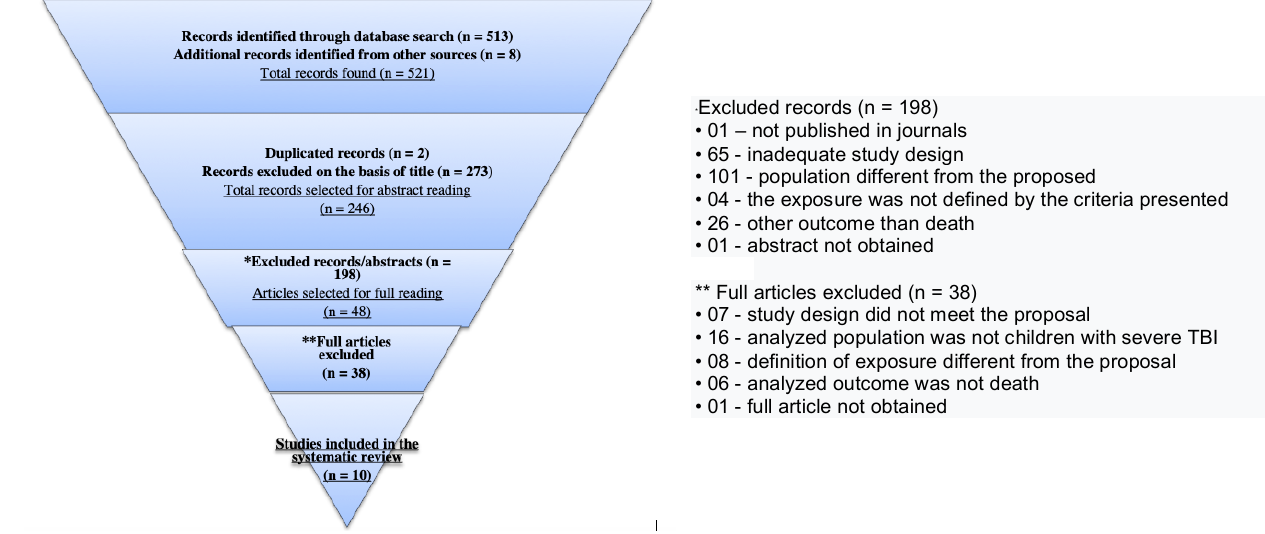
Figure 1 – Selection process for inclusion and exclusion of scientific studies during the preparation of the systematic review on prognostic models of mortality in children and adolescents victims of severe traumatic brain injury (TBI)